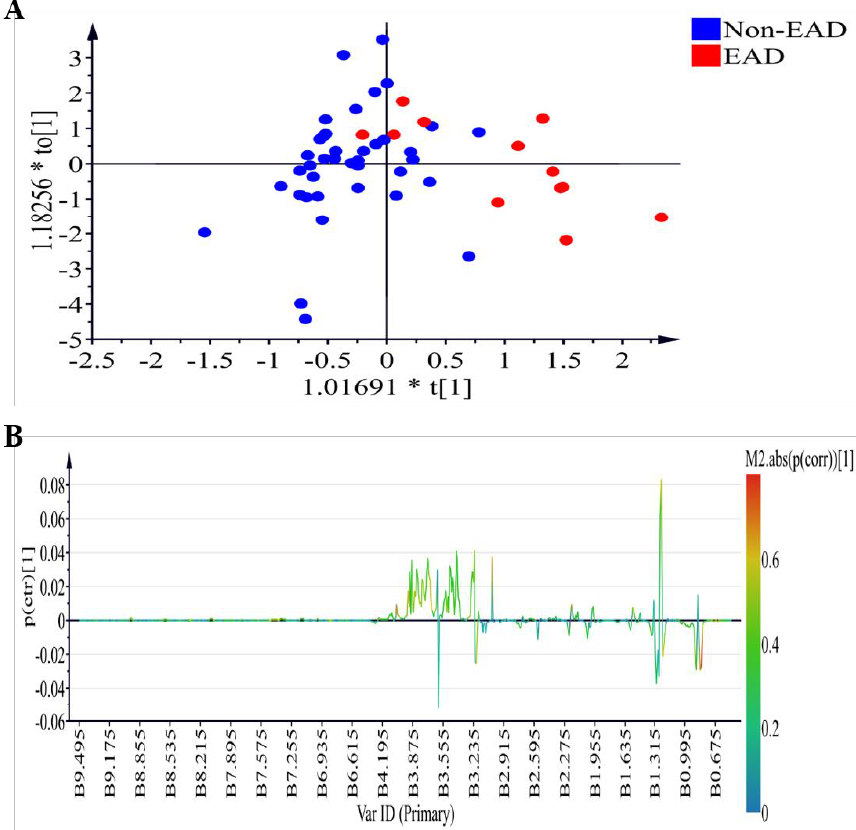
Figure 2. Plasma samples analyzed by 1 H-NMR in the comparison of the EAD and non-EAD patients on postoperative day 7 (T6). ( A ) OPLS-DA scores plot presenting T6 EAD (red) and T6 non-EAD (blue) with fitness and predictive power R 2 X = 0.691, R 2 Y = 0.521, Q 2 = 0.219. ( B ) OPLS-DA loading coefficient plot showing that the difference between the EAD and non-EAD groups. 1 H NMR, 1 H-nuclear magnetic resonance spectroscopy; OPLS-DA, orthogonal projection to latent structures-discriminant analysis; EAD, early allograft dysfunction.